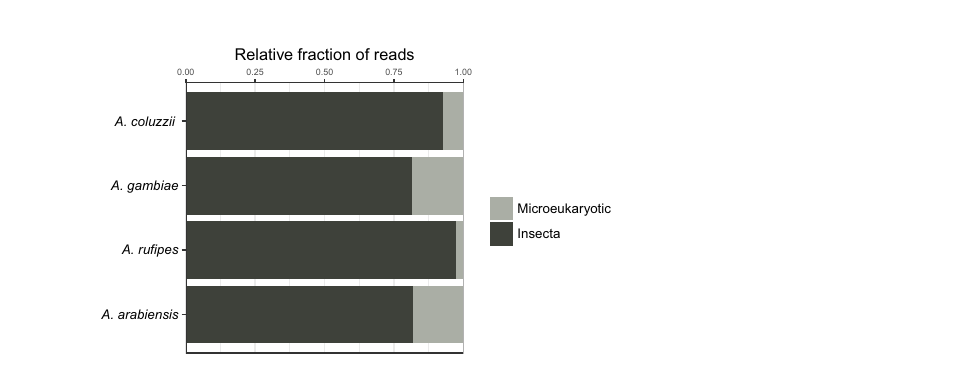
Figure 8. PNA blocking efficiency across multiple Anopheles species. Proportions of sequence reads assigned to insects (dark grey) and eukaryotic microbes (light grey) are showing 4 Anopheline species. Approximate evolutionary divergences 40 of each species from A . coluzzii are, A . gambiae , 0.5 million years; A . arabiensis , 1.8 million years ; and A . rufipes , > 20 million